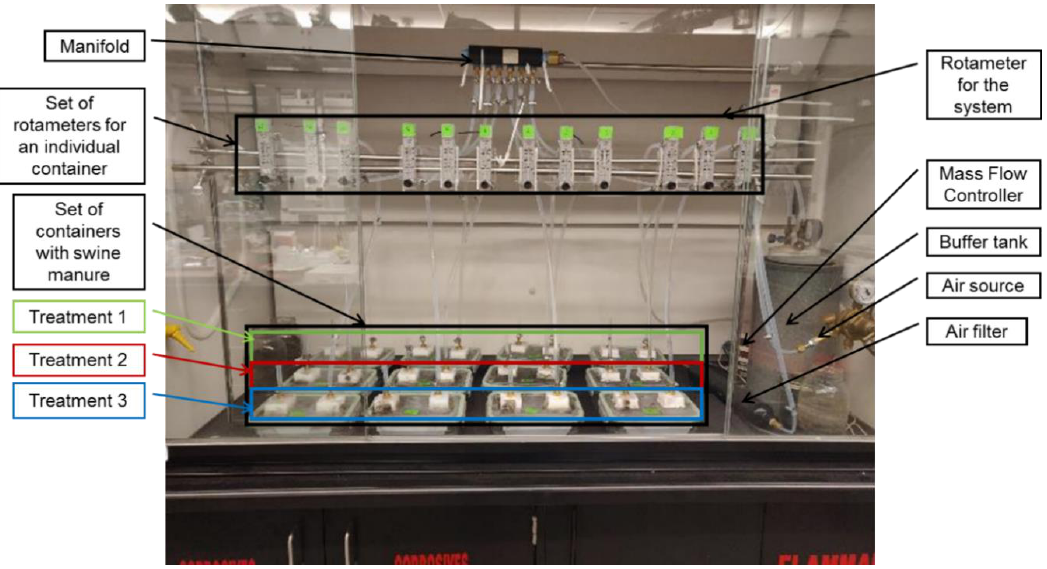
Figure 1. A laboratory-scale system to test the effects of surficial biochar application to swine manure on gaseous emissions. on gaseous